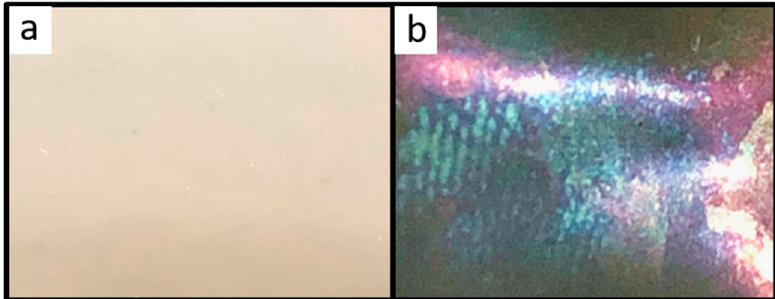
Figure 7. ( a ) Photographic picture of the filled opal film based on SiO 2 @P(TFEA- co -NFHMA- co - i BuMA) core/interlayer/shell particles, without reflection colors; ( b ) photographic picture of the inverse opal film based on SiO 2 @P(TFEA- co -NFHMA- co - i BuMA) core/interlayer/shell particles, with reflection colors. The cutout of the inverse opal discs featured a diameter of 2 cm.